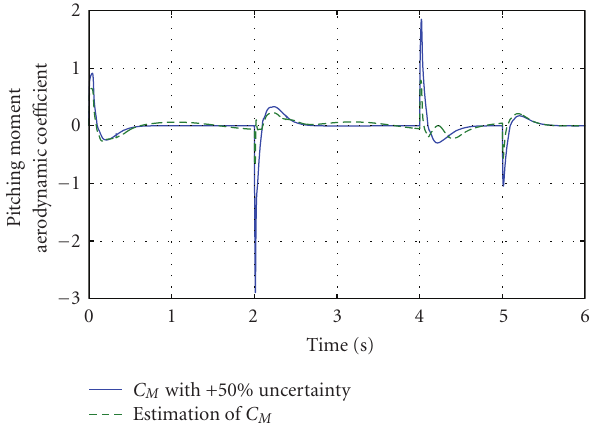
Figure 6: Pitching moment aerodynamic coe ffi cient estimation with adaptive scheme.